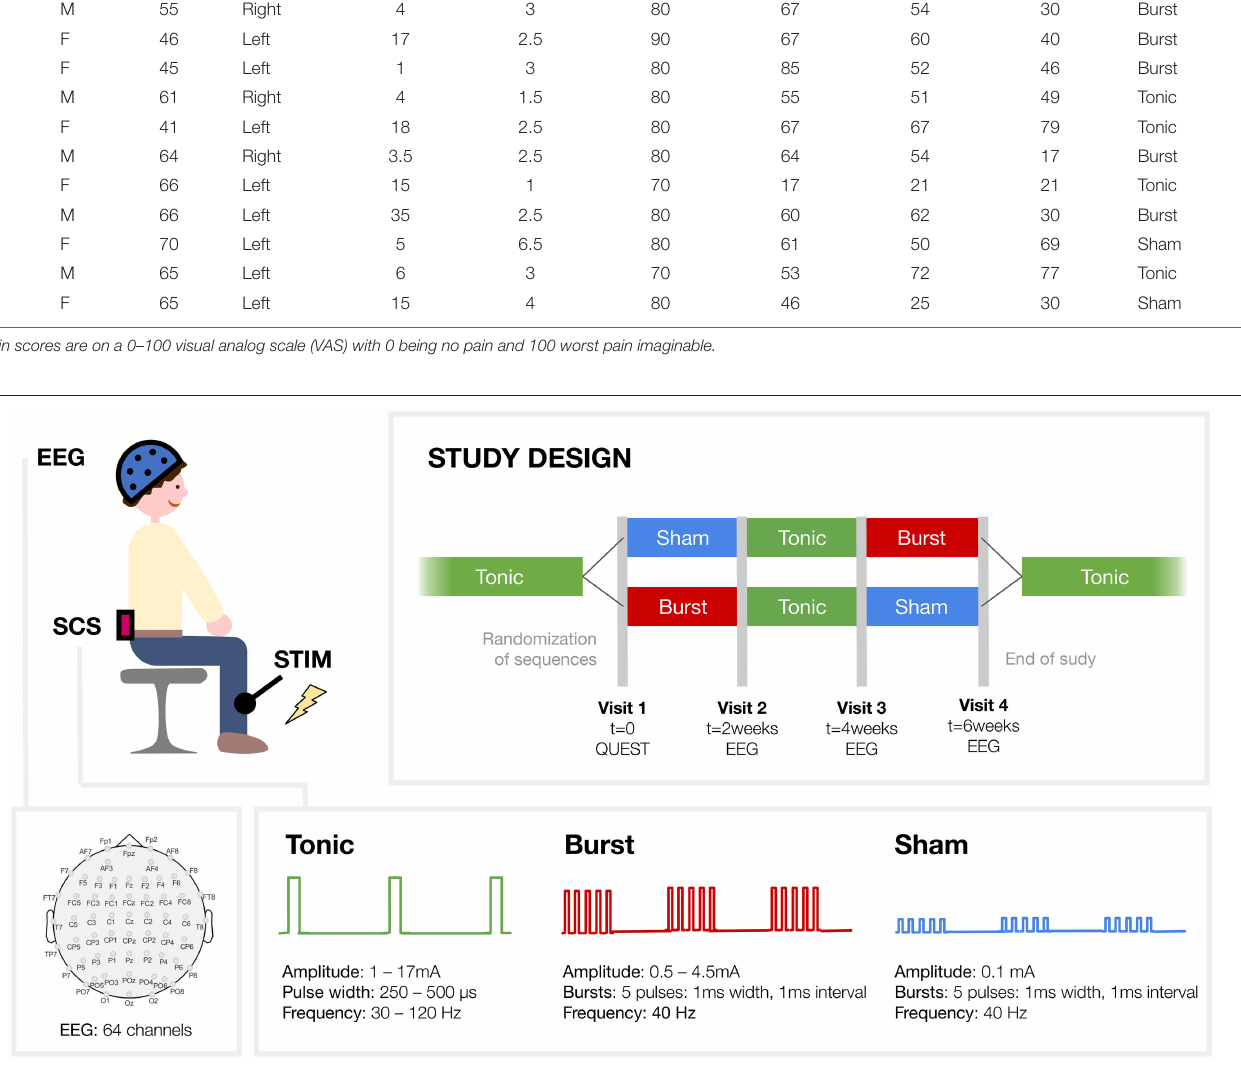
average VAS score for pain of 79 (range: 70–90). The